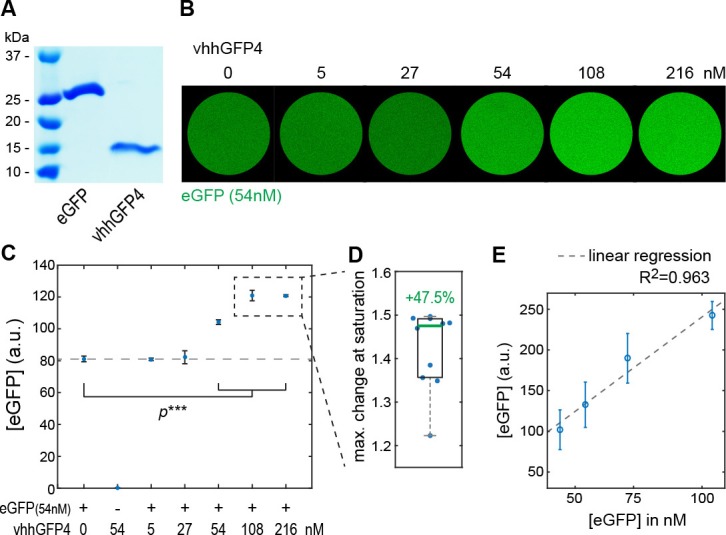
Modulation of EGFP fluorescent properties by vhhGFP4 binding in vitro.(A) Coomassie staining of SDS-PAGE loaded with purified eGFP (25 kDa) and vhhGFP4 (14 kDa). See Materials and methods for details. (B) Fluorescence in vitro essay to estimate changes in eGFP fluorescence upon binding to vhhGFP4. Titration of defined amounts of purified vhhGFP4 on 54 nM purified eGFP. (C) Quantification of eGFP fluorescence as shown in (B). vhhGFP4 concentrations of 54 nM and higher resulted in a significant increase in fluorescence levels (two-sided t-test with equal variance, ***p≤0.0005). Plot shows average values from five independent replicas; error bars represent the standard deviation. (D) At saturating vhhGFP4 concentrations (108 nM and 216 nM vhhGFP4), we observed a mean increase of 47.5% (1.475-folds) in eGFP fluorescence levels. Individual data points from the 108 nM and 216 nM experiments from all five replicas are plotted and were included in the calculations; the green line represents the median. (E) To test if fluorescent levels reflect changes in protein concentration, defined amounts of eGFP were imaged (43.5 nM, 54.4 nM, 72.5 and 108.8 nM) under the imaging conditions used for the experiments shown in (B–D). Indeed, the obtained fluorescence levels increased proportionally to the respective eGFP concentrations. Hence, our imaging conditions were within the linear range of the fluorophores and suitable to detect changes in eGFP fluorescence.DOI:
http://dx.doi.org/10.7554/eLife.22549.00910.7554/eLife.22549.010Figure 2—figure supplement 2—source data 1.Source data pannels C-E.